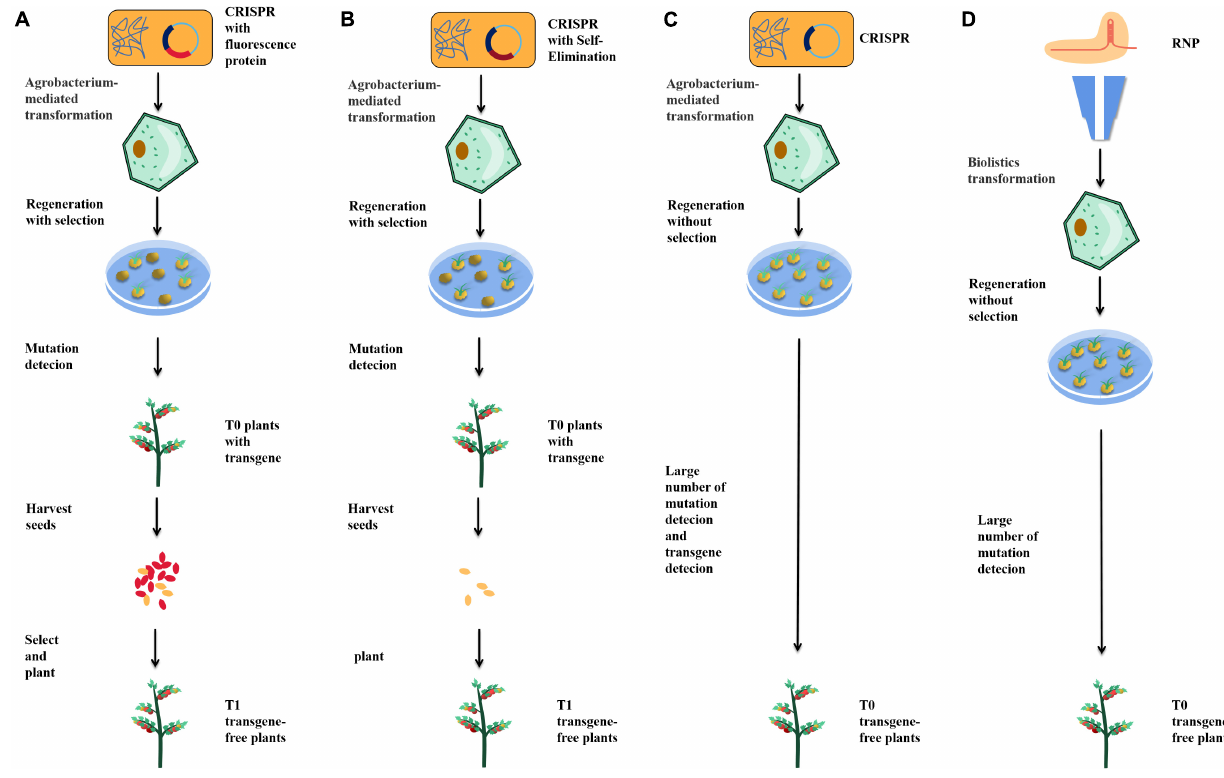
further research is needed to select and understand how to encapsulate the